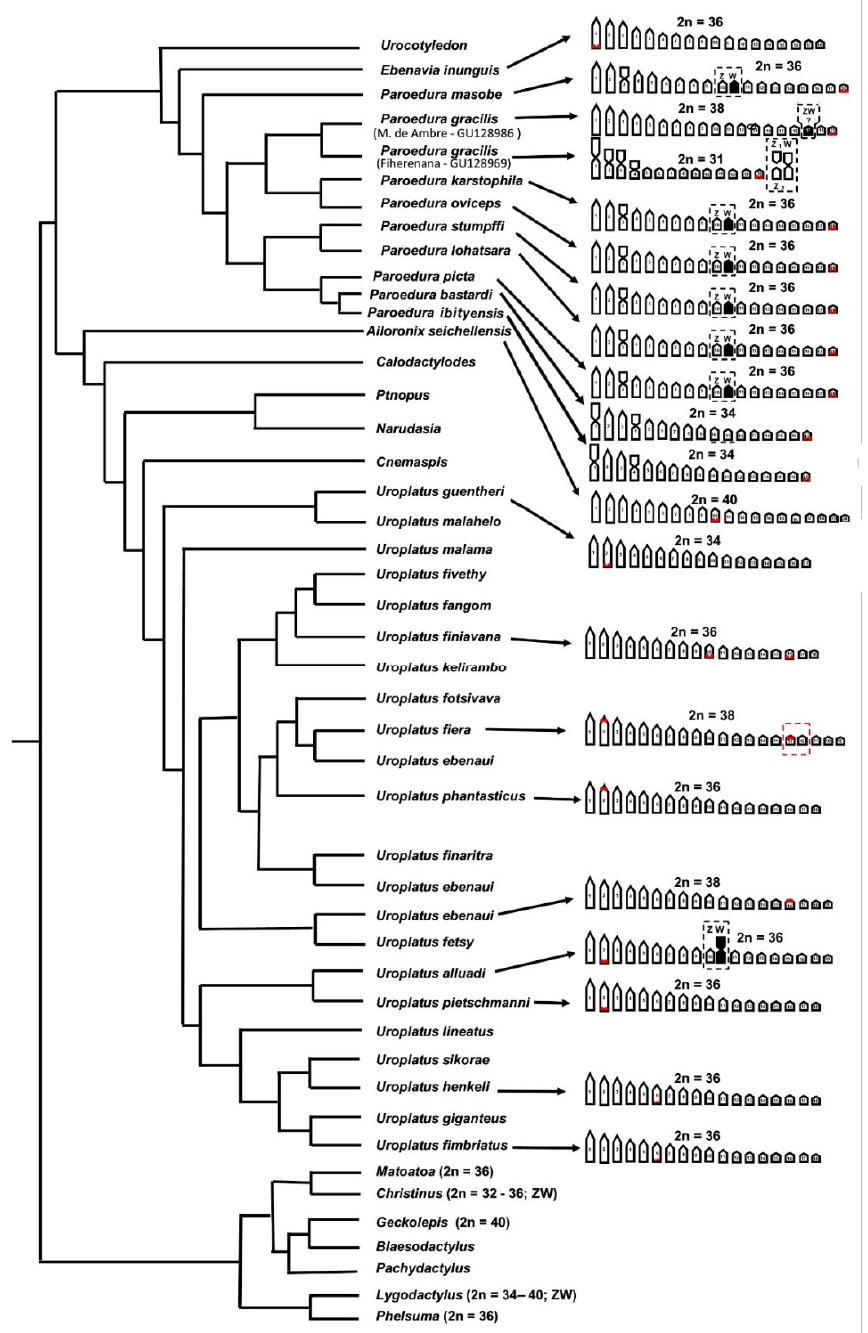
Figure 5. Hypothesized scenario of chromosome diversification in phylogenetically related leaf-toed geckos. Available karyological data from the literature [6,8,9,24,26,44,46–48] are superimposed on the phylogenetic tree by Pyron et al. [25], with relationships of the U. ebenaui group by Ratsoavina et al.